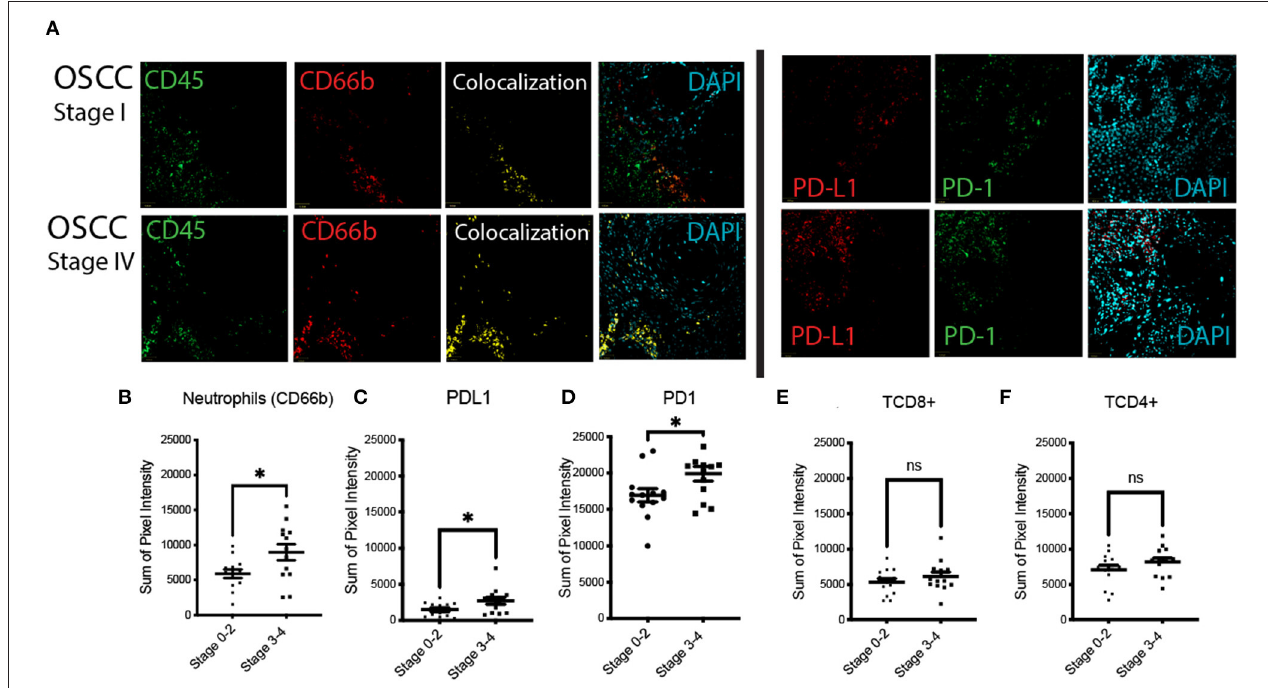
FIGURE 4 | Expression of CD45, CD66b (neutrophils), PD-1/PD-L1 in low stage (Stage I and II), and high stage (Stage III and IV) OSCC. (A) Fluorescent immunohistochemistry (FIHC) stained samples showing aPD-1/PD-L1 and neutrophils (colocalized CD45 and CD66b) in stage IV OSCC samples compared to stage I.